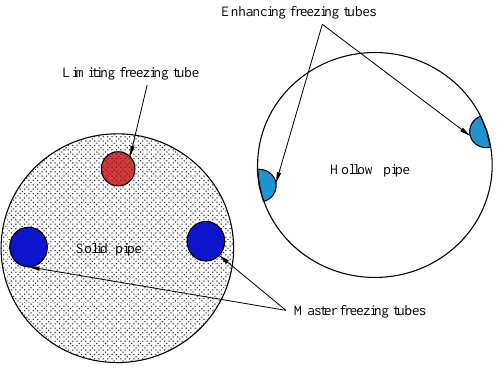
Figure 3. The layout of freezing tubes.